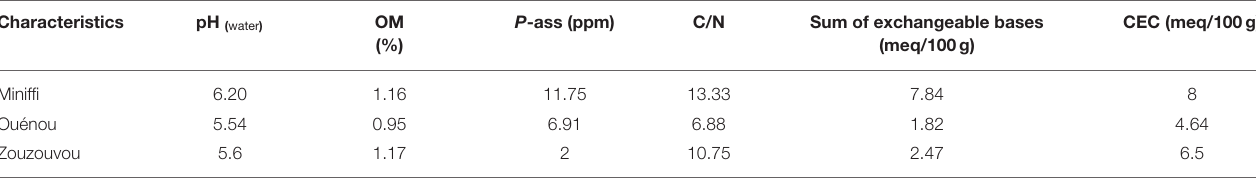
TABLE 1 | Chemical characteristics of the study soil. Characteristics